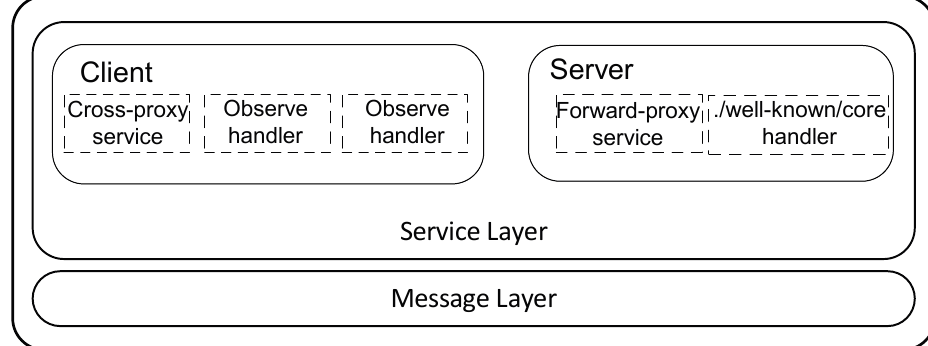
Figure 10. CoAP module